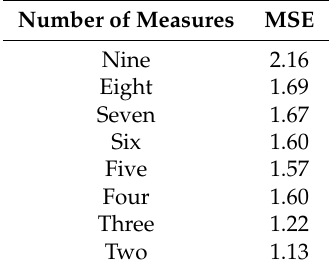
Table 8. MSE of different combinations of the similarity and distance measures for the user-based CF with an average aggregation